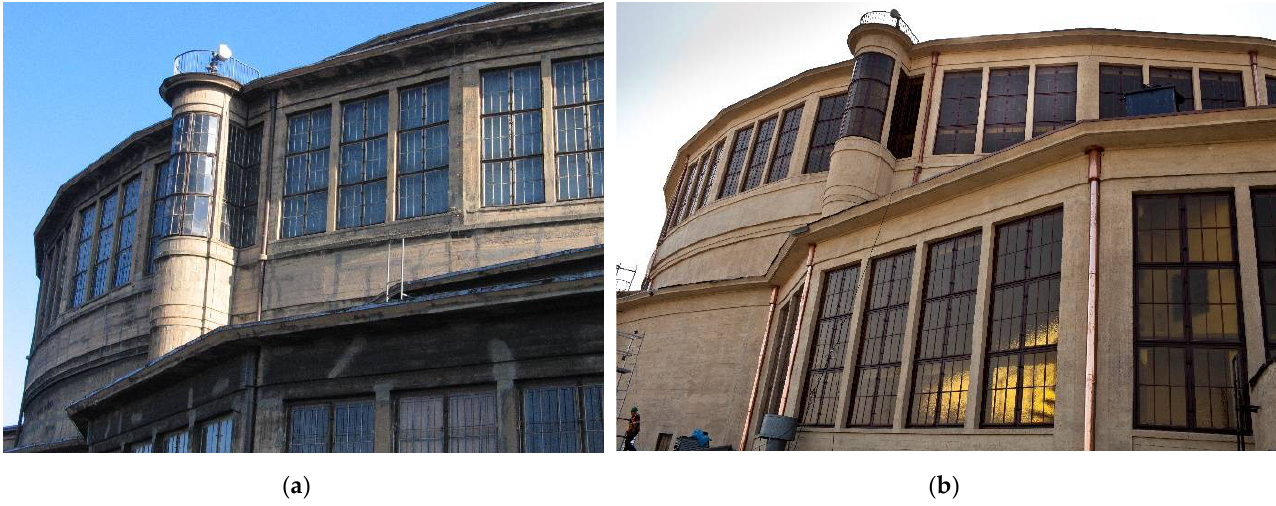
Figure 16. Centennial Hall: ( a ) before renovation (photo J. Ilkosz) and ( b ) after renovation in 2009 (photo J. Ilkosz).